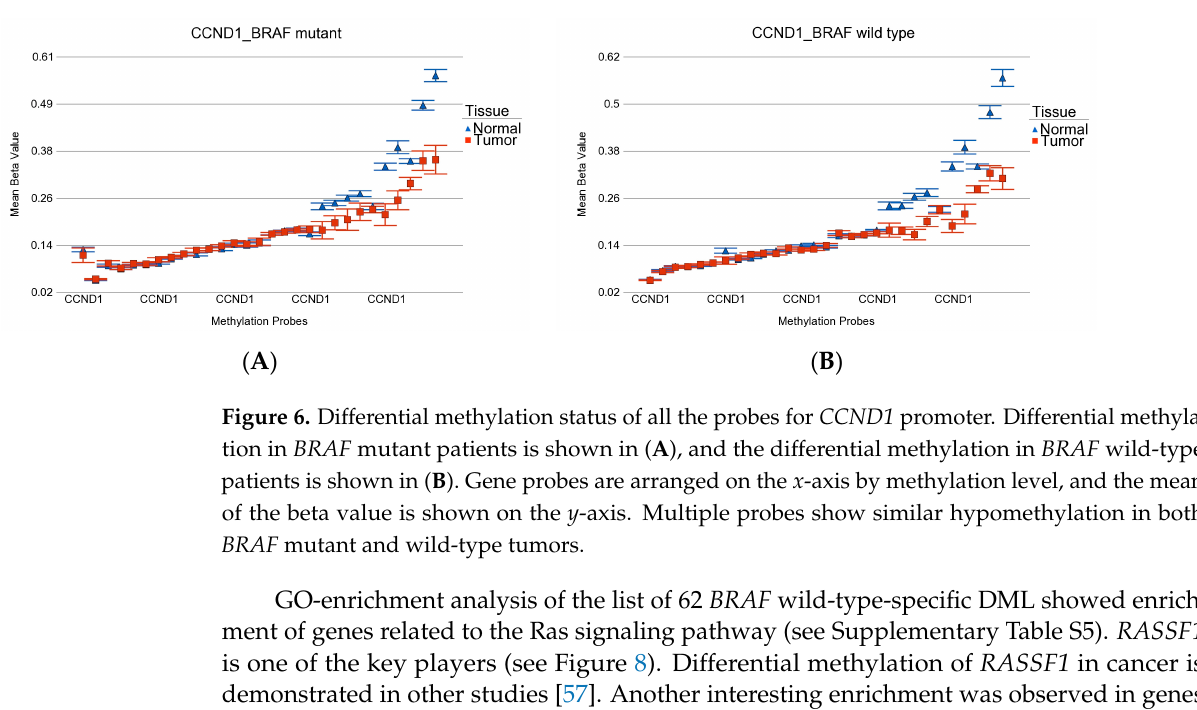
Figure 5. Enrichment score of the 51 common DML in thyroid cancer.